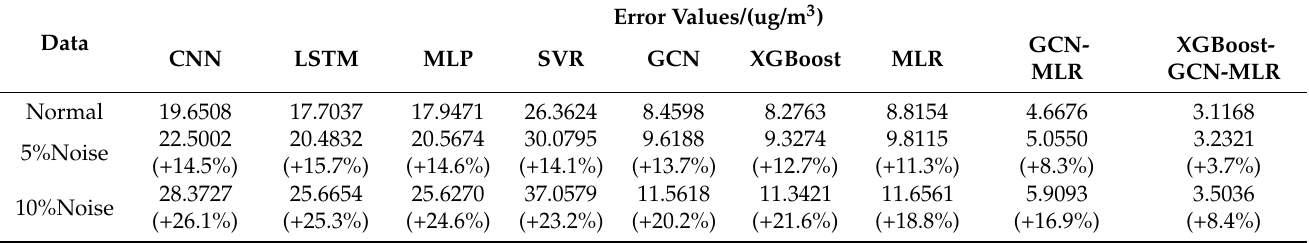
Table 6. Comparison of mean absolute error of VOCs in Xi’an.